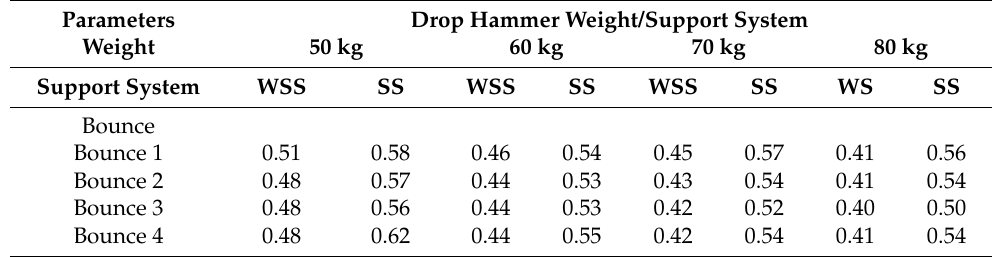
Figure 6. Relative amounts of absorbed energy. Table 1. Average values of the relative amount of absorbed